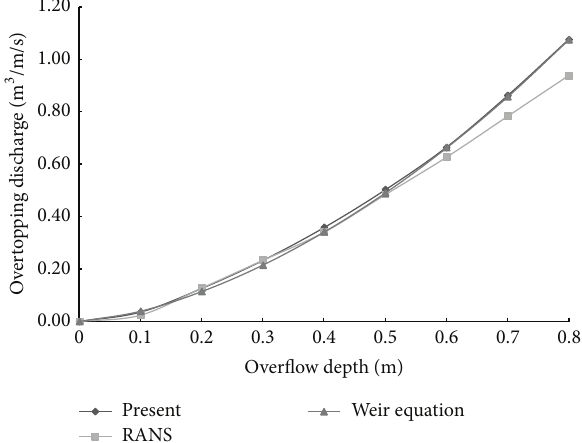
Figure 2: Comparison of the overtopping discharge rate obtained with the NSE models and the weir